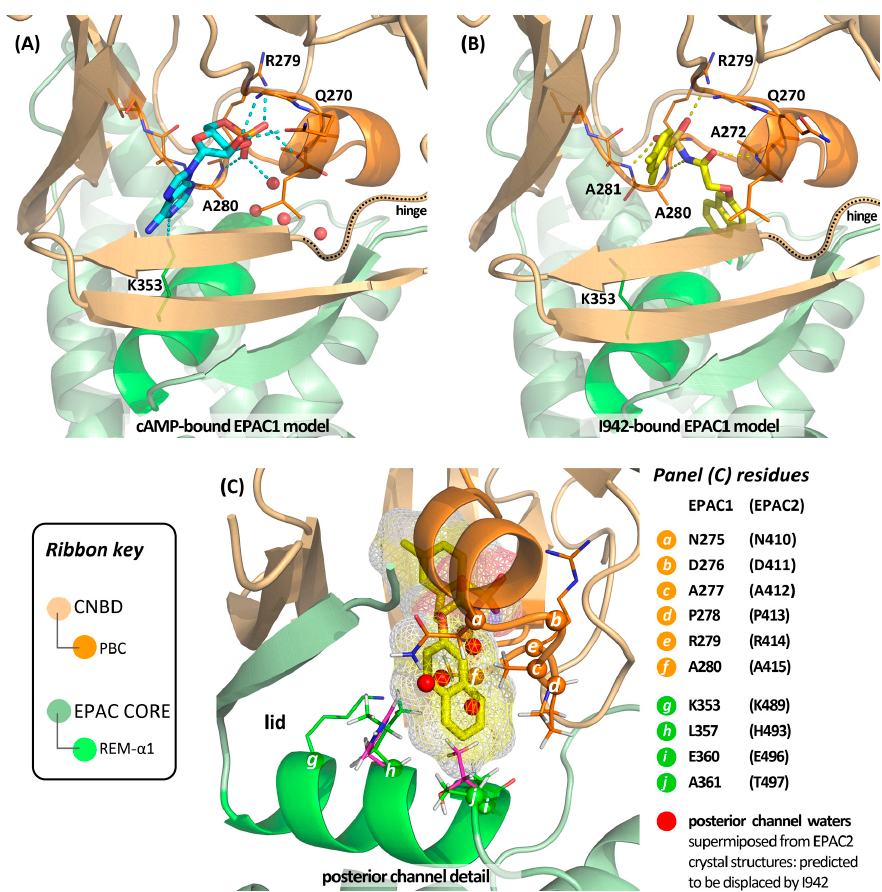
Figure 5. Modelling studies with EPAC1 homology models suggest that I942 may engage the cyclic nucleotide binding domain-B (CNBD-B) with subsequent hinged closure of the domain onto the protein core leading to a “threaded” binding mode and adoption of an active-state EPAC conformation. In this binding mode (panel ( B )) the acidic N -acylsulfonamide is predicted to occupy the position of the endogenous ligand’s phosphate (panel ( A )) and form extensive phosphomimetic hydrogen bonds (dashed lines) with the protein’s phosphate-binding cassette (PBC, bright orange ribbon). EPAC2 co-crystal structures show that the cyclic AMP adenine binds in a large funnel-like channel that opens on the front face of the protein as figured in panel ( A ), where the adenine N1 centre engages a lysine (conserved as K353 in EPAC1) on the REM domain’s helix- α 1 (bright green ribbon). An additional smaller opening, the posterior channel, communicates to the reverse face of the protein. Cyclic AMP does not directly utilise this volume, which is occupied by water molecules in available EPAC2 co-crystal structures (marked as red spheres in the panel ( A ) model). We postulate that this posterior channel, which is heavily hydrophobic, hosts the naphthyloxy group of I942, as detailed in panel ( C ). Occupancy of this channel may be entropically favoured by displacement of water (shown superimposed as red spheres in panel ( C )), and stabilise closure of the CNBD onto the EPAC1 core by interaction of the naphthyl subunit with REM- α 1 residues L357, E360 and A361 ( h , i and j in panel ( C )). L357 and A361 are not conserved across the EPAC isoforms, which may account for the observed selectivity of I942, as the cognate EPAC2 residues (H493, T497; magenta stick) are predicted to interdict I942 binding. In the EPAC active conformation the REM- α 1 helix folds as a lid onto the ligand binding site due to reorganisation of the EPAC hinge sequence (dotted ribbon in panels ( A , B )). Whilst the naphthyloxy group may favourably engage the surface of REM- α 1 at the C-terminal end, it fails (in contrast to cyclic AMP) to engage K353 at the N-terminal end. This may influence equilibrium position between CNBD-B open and closed states, with weaker overall engagement of the REM- α 1 lid by I942 (or/and ligand-specific domain seating penalties) accounting for the observed EPAC1 “partial agonism” relative to the endogenous ligand.